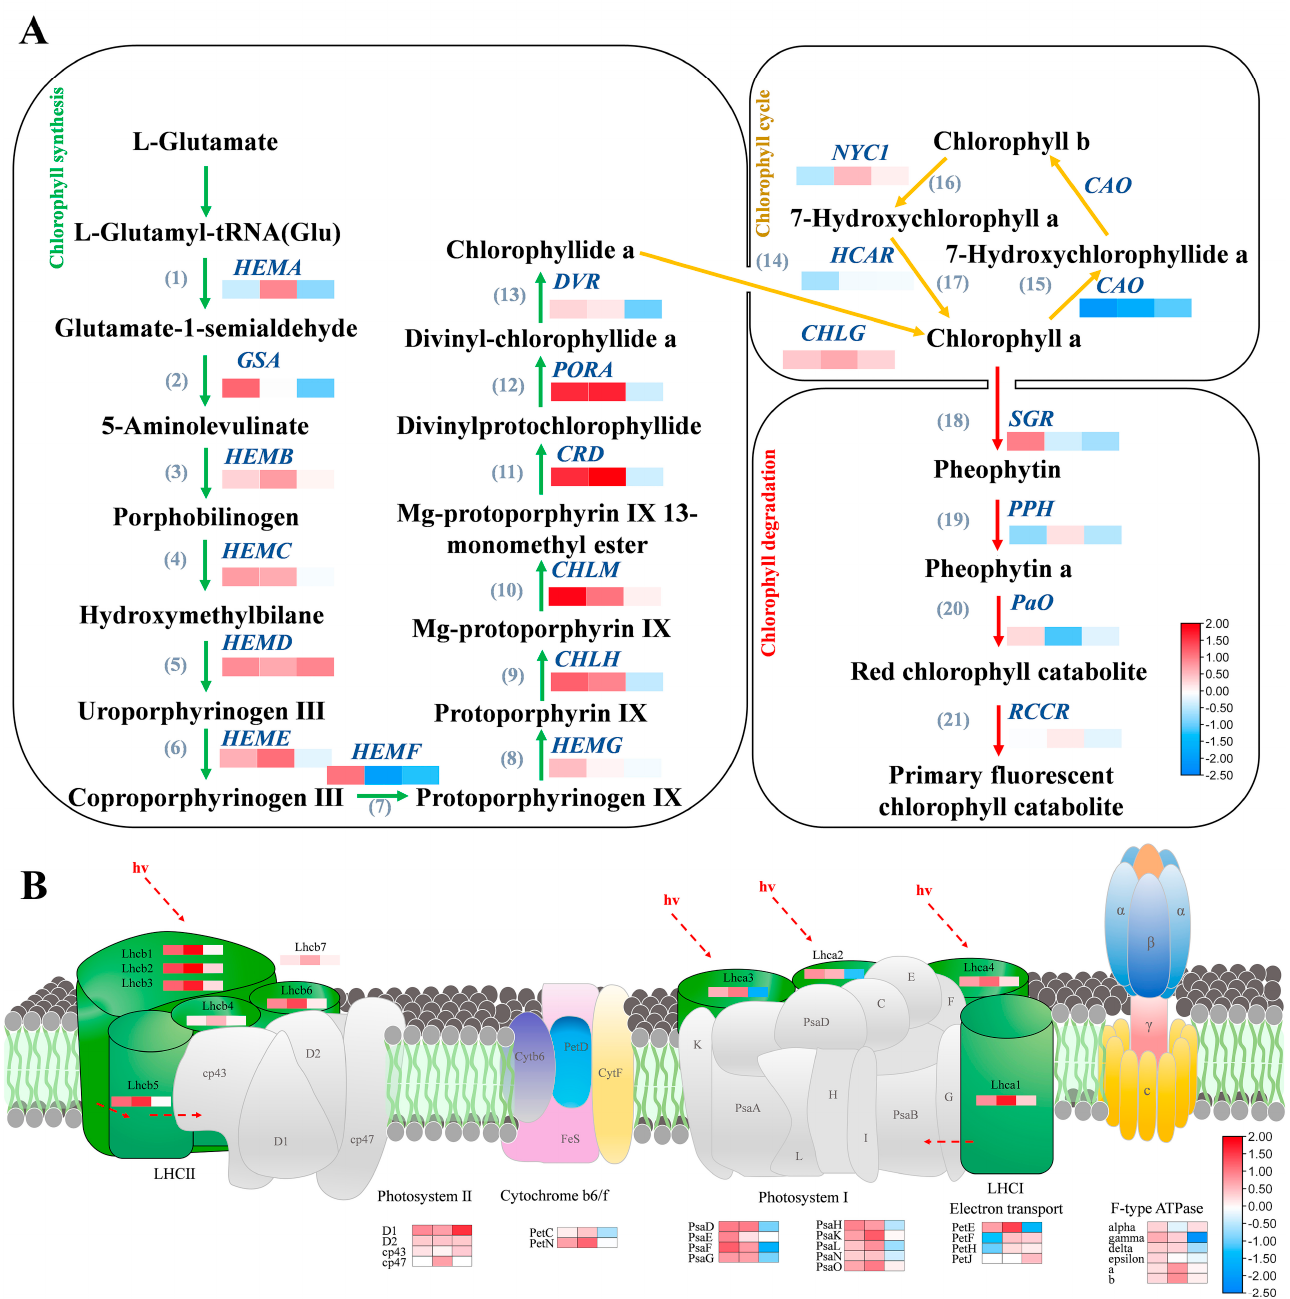
Figure 4. Chl metabolism and photosynthesis pathway-related genes are differentially expressed in ZX12/ZX4 at 20, 30 and 40 DAF time. ( A ) Heat map of Chl metabolism gene expression. ( B ) Heat map of key gene expression in photosynthesis pathway. The value of the heat map is the log 2 (ZX12/ZX4) value of the ratio of the expression in RNA-seq.